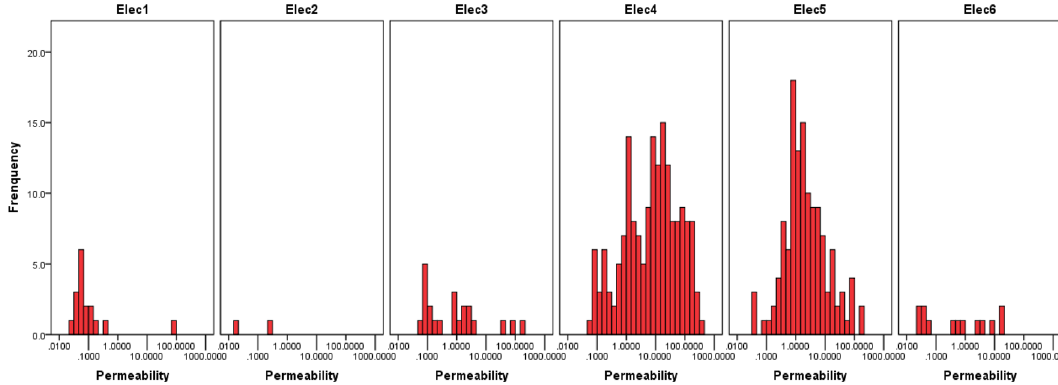
Fig. 4 Overall distribution of permeability in electrofacies categories